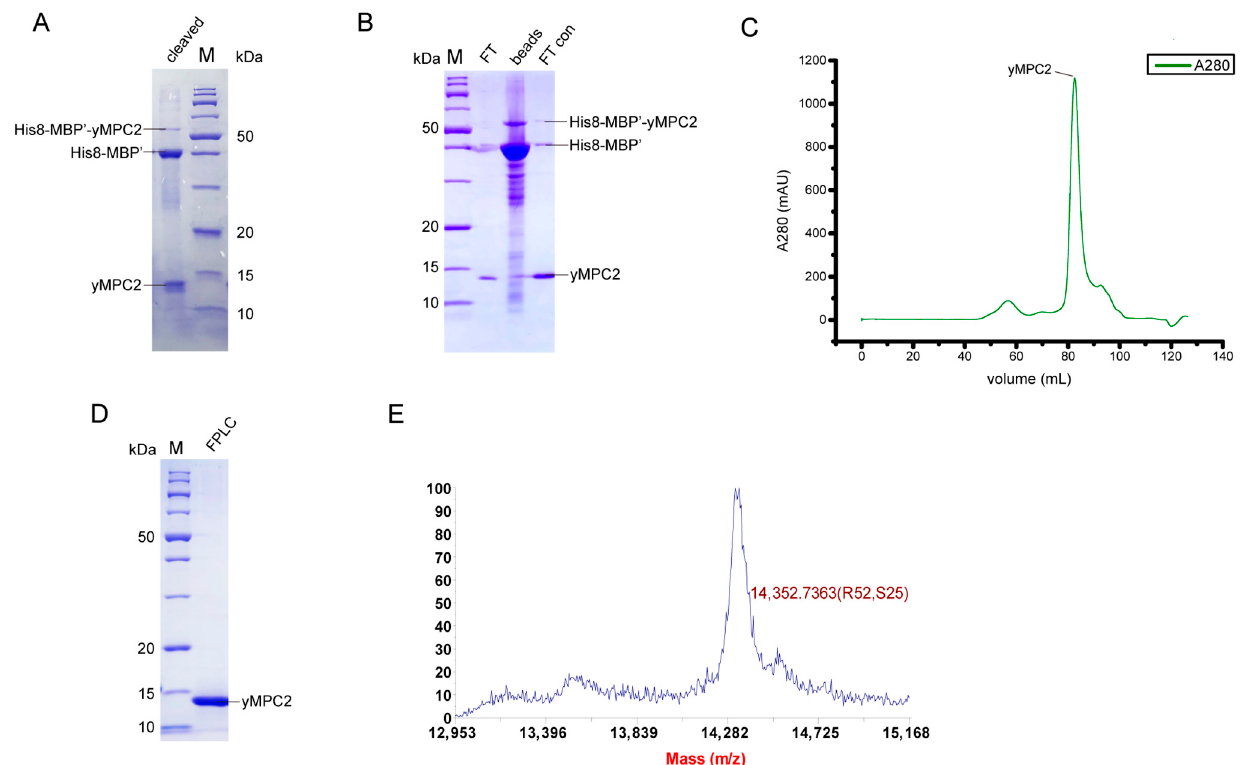
Figure 2. Protein purification of yMPC2. ( A ) SDS-PAGE analysis of the CNBr cleavage products of His8-MBP ′ -yMPC2. The protein bands were detected by Coomassie blue staining and are indicated by a line. ( B ) SDS-PAGE analysis of the protein purity after removing uncleaved His8-MBP ′ -yMPC2 and His8-MBP ′ -tag by nickel affinity resins. The labels in the figure are indicated as below: “FT” is the flow through; “beads” is the supernatant from the boiled nickel affinity resin; and “FT con” is the concentrated flow through. ( C ) Size exclusion chromatography of yMPC2 in SEC buffer (100 mM NaCl, 2.8 mM DPC, 0.5 mM β -ME, 50 mM MES pH 6.5) using a HiLoad 16/60 pg Superdex 200 GE column. ( D ) SDS-PAGE analysis of the elution peak from size exclusion chromatography in ( C ). ( E ) Mass spectrometry analysis of the purified 14 N-yMPC2 protein. The experimental molecular mass is 14 , 352.74 Da, consistent with the theoretical molecular mass of 14,357.49 Da.